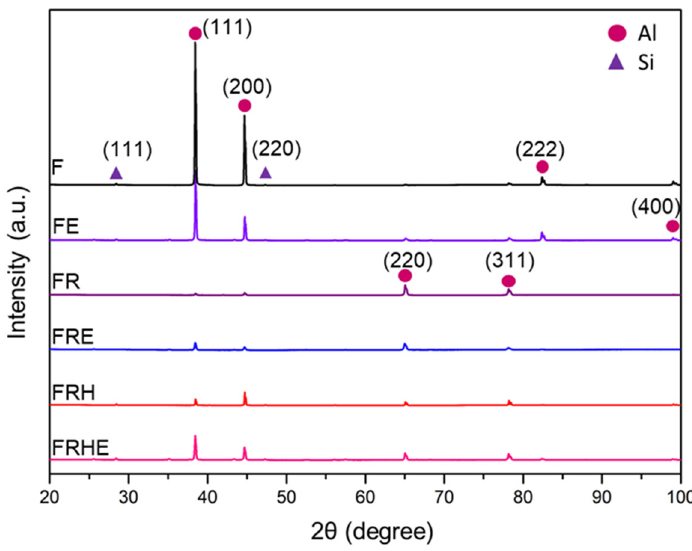
Figure 9. The XRD analysis of the erosion surface of each specimen before and after erosion. Table 4. Comparison of the material application properties ( ● : be tt er) .